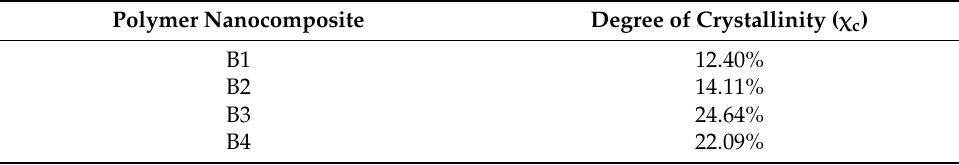
Table 2. Degree of crystallinity for the nanocomposites B1, B2, B3, and